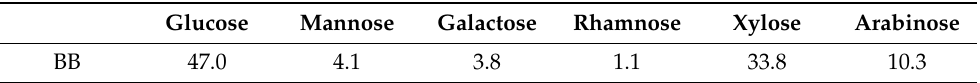
Table 2. Carbohydrate composition of BB in % of total neutral monosaccharides [62].